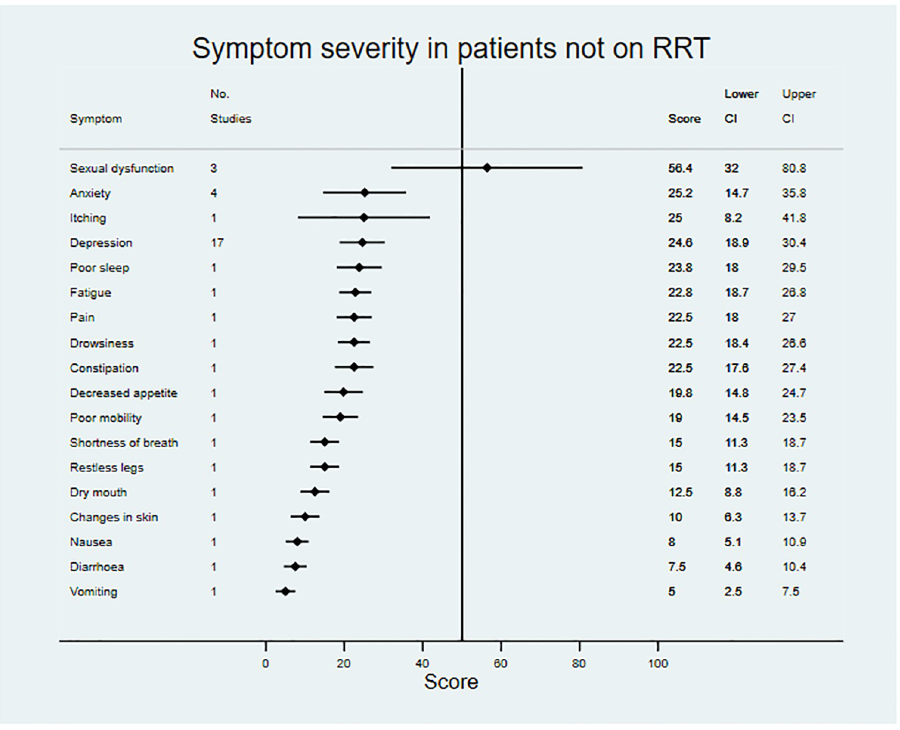
Fig 5. Pooled symptom severity across included studies for patients not on renal replacement therapy. Scores represent mean severity scores converted to a 0–100 scale, where a higher score indicates greater severity; vertical line at 50 for reference. RRT, renal replacement